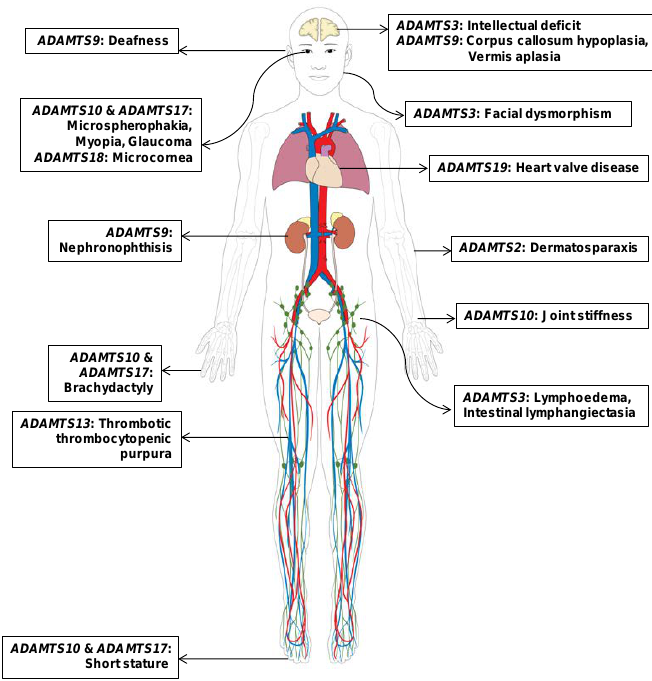
Figure 2. Clinical findings and distribution of affected organs in individuals with Mendelian disorders caused by pathogenic mutations in different ADAMTS family genes. Predominant and recurrently reported clinical presentations of eight ADAMTS genes with a strong causal relationship to Mendelian disorders are marked according to organ. Heterogeneous distribution of affected organ types indicates the phenotypic heterogeneity among hereditary disorders caused by pathogenic germline mutations in ADAMTS genes.